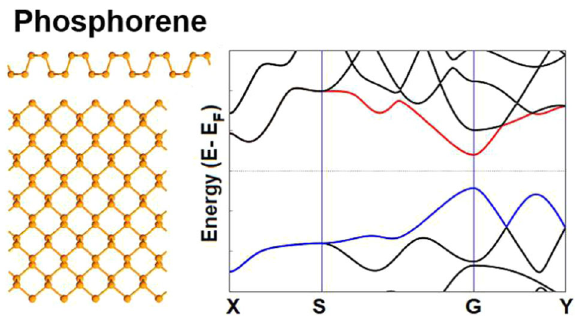
Fig. 14 Structure and Electronic Properties of Phosphorene. The side-view and top view representations (5 × 5 × 1 Supercell) of the monolayer Phosphorene and its energy-crystal wave vector (E-k) dispersion relations where the conduction band and valance band are marked in red and blue,